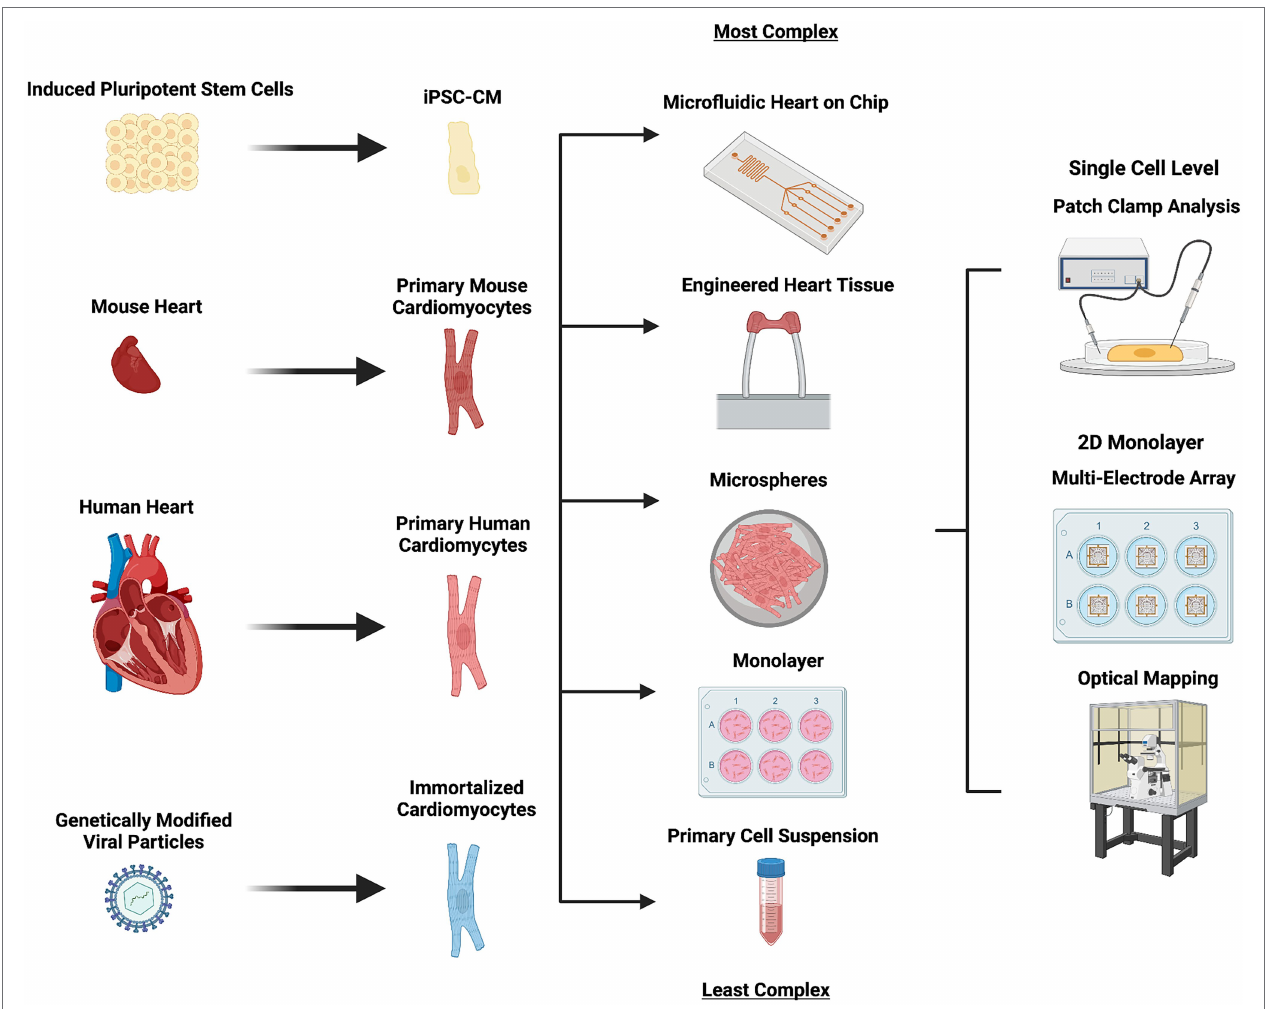
FIGURE 2 | In vivo models used in cardiac arrhythmia and heart failure research. An outline of the in vitro cell models used in arrhythmia and heart failure research, how they are derived (left), the format in which they can be used (middle right) and the techniques most commonly used in their evaluation (right). Complexity of the model used increases from bottom (primary cell suspension) to top (microfluidic heart on chip). Created with